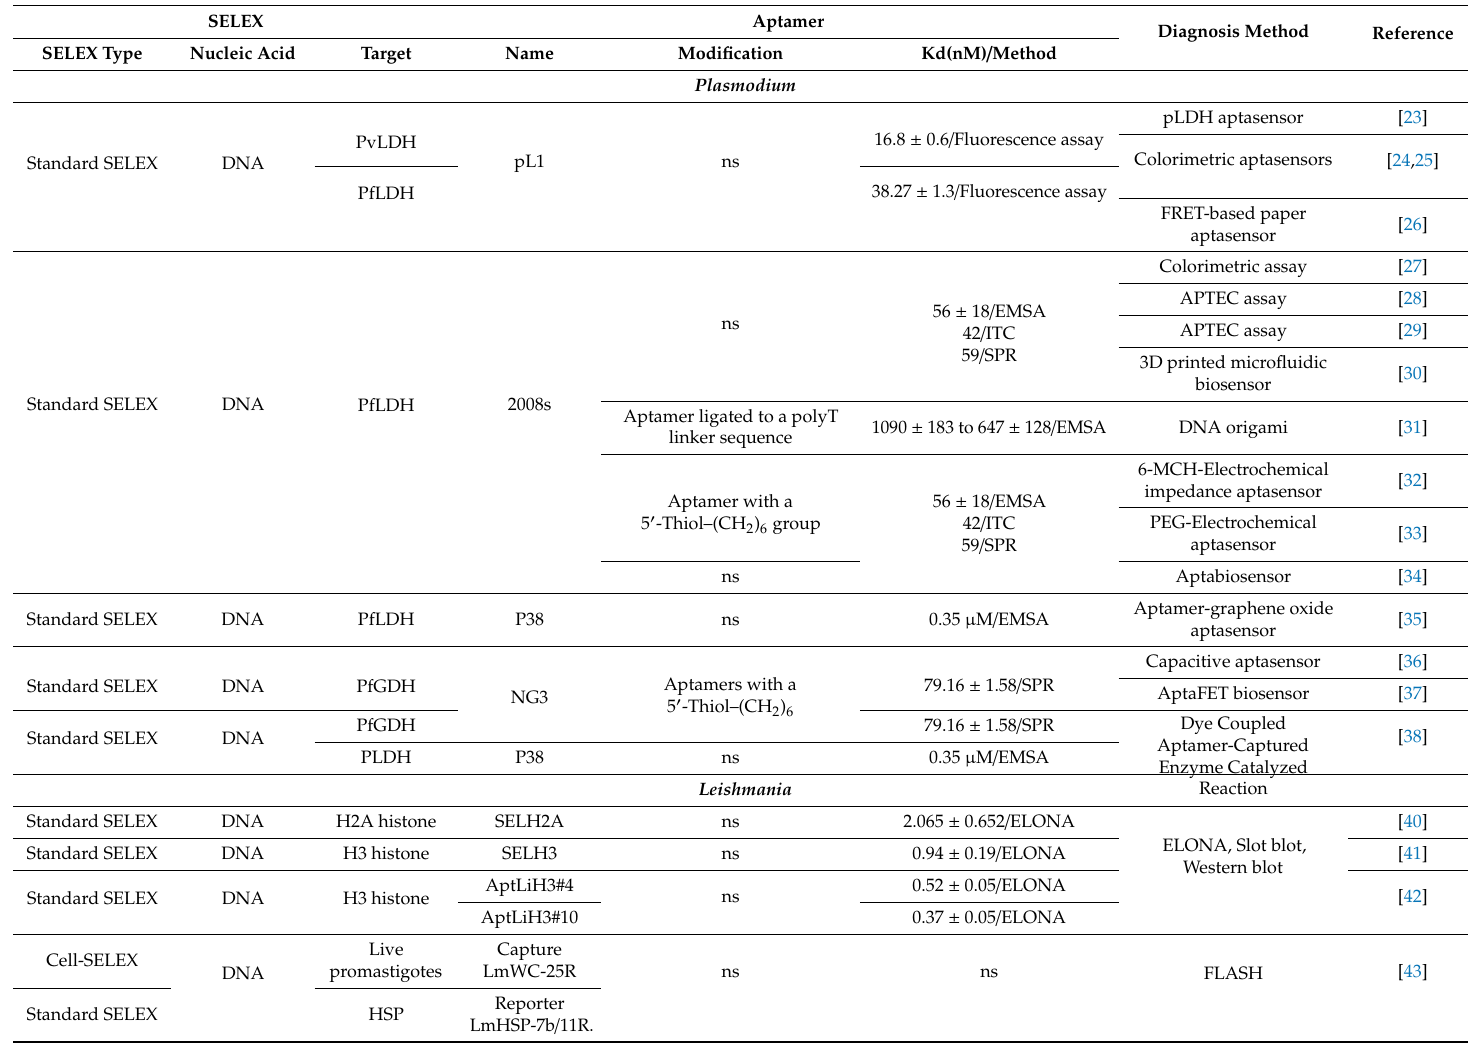
Table 1. Aptamer-based diagnosis methods of infectious diseases caused by